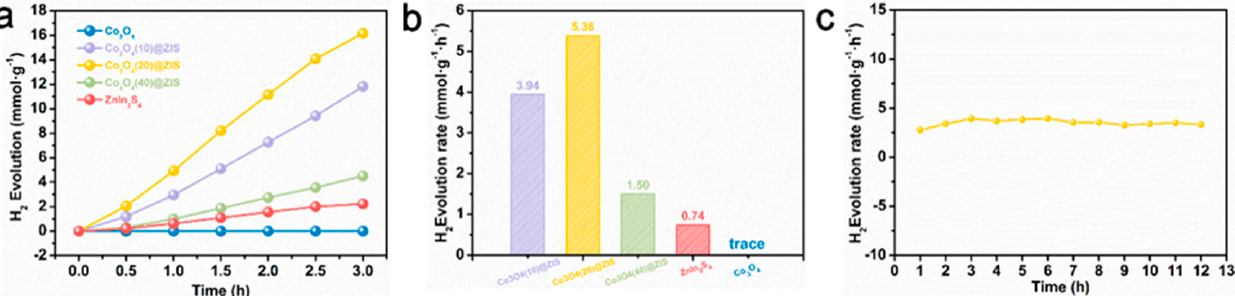
Figure 7. ( a ) Plot of total hydrogen production for each sample; ( b ) Plot of hydrogen production rate for each sample;( c ) Long time hydrogen production rate of Co 3 O 4 (20)@ZIS.